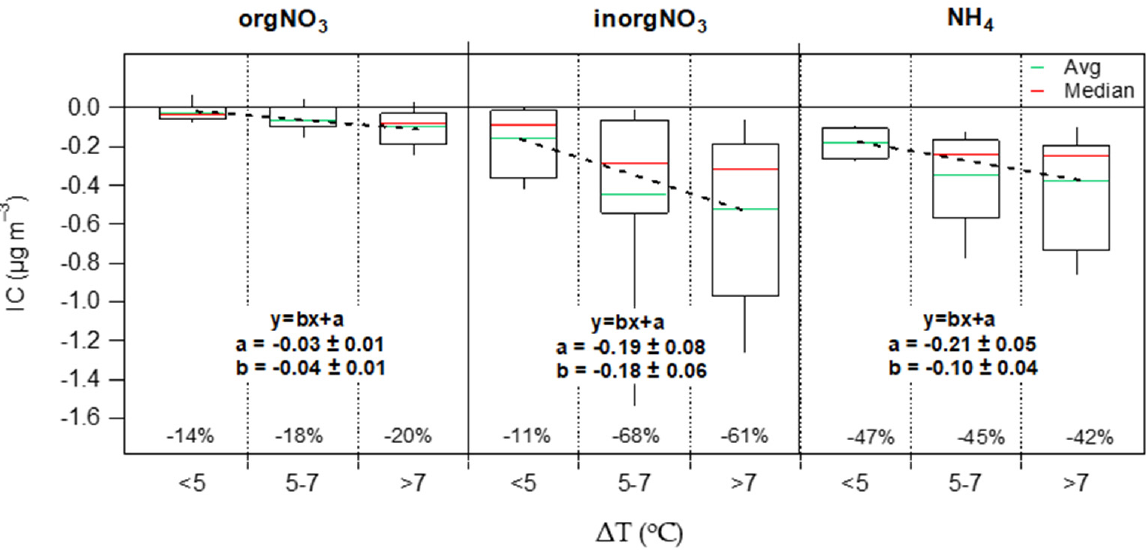
Figure 11. Indoor contribution of orgNO 3 , inorgNO 3 and NH 4 as a function of indoor-outdoor temperature differences. The boxes and whiskers ( bottom to top ) represent the 10th and 25th percentiles, median (red line), and the 75th and 90th percentiles. Green lines represent average IC. Percentages correspond to the relative indoor contribution (RIC = IC/OC) for each bin.